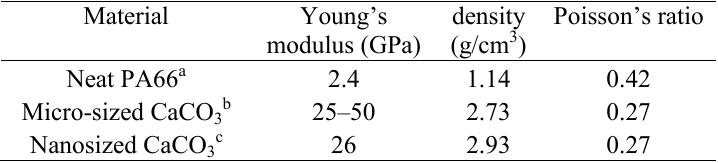
Fig. 1. TEM photomicrograph of the nano-CaCO .[in this study